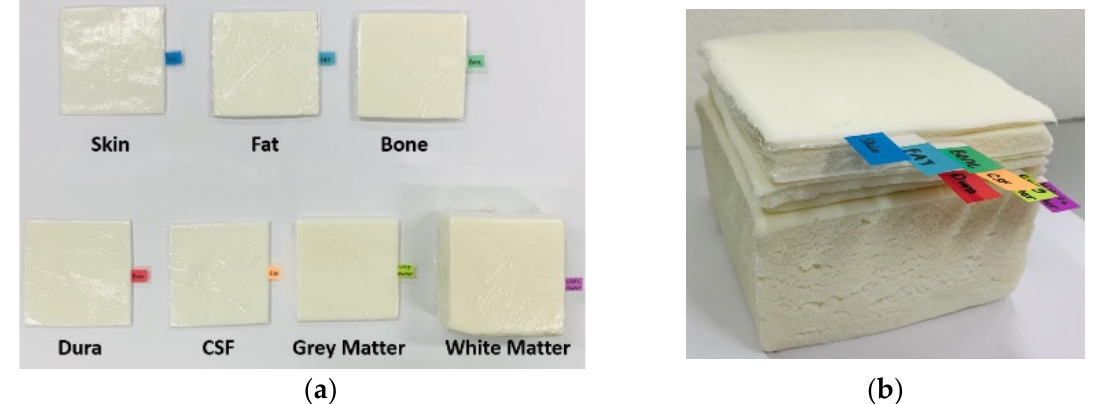
Figure 7. Fabricated brain-tissue-emulating materials: ( a ) pictures of each layer and ( b ) stack-up.